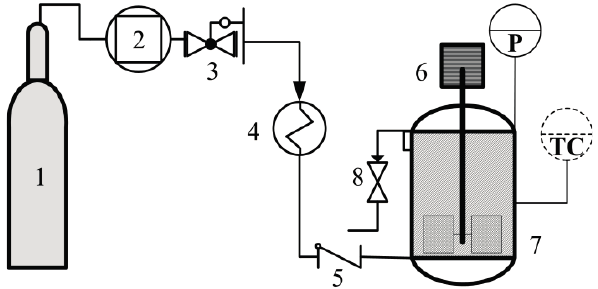
Figure 10. Illustration of the experimental setup: 1 , CO pressure regulator; 4 , preheater; 5 , check valve; 6 , mechanical stirrer; 7 , reactor; 8 , outlet valve; TC, temperature controller; P, pressure